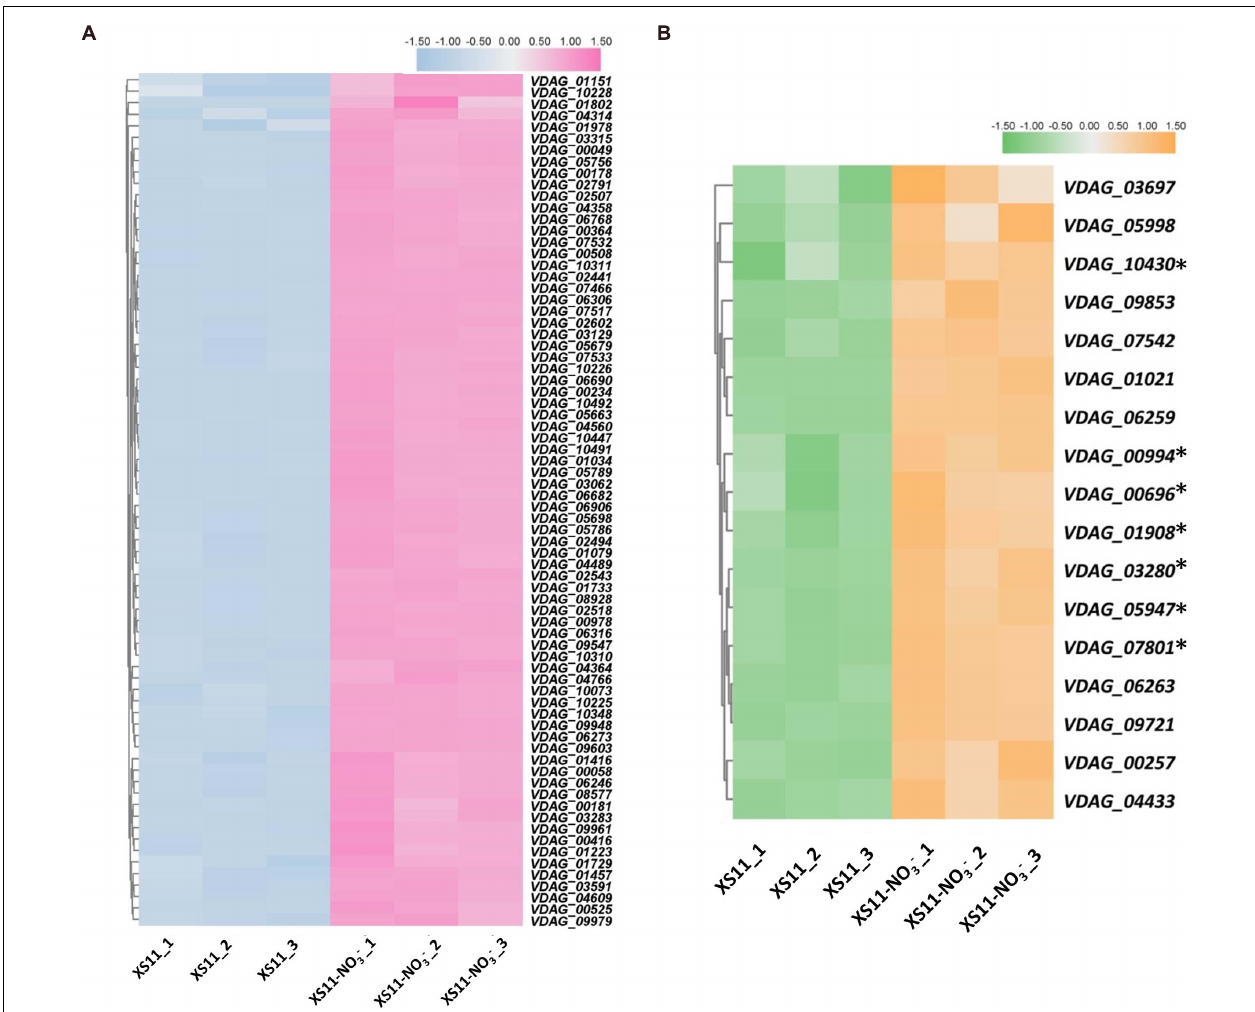
FIGURE 5 | Heat maps of differentially expressed genes related to ribosome and RNA polymerase processes in response to nitrate as the sole nitrogen source in Verticillium dahliae. (A) Heat map showing the relative expression of genes related to ribosome in the V. dahliae XS11 strain using nitrate (NO 3 − ) and in the control. TBtools was used to normalized data and generate heat map. The pink color indicates expression was relatively higher, while blue color indicates expression was relatively lower. White indicates that the gene expression between conditions analyzed was unchanged. (B) Heatmap of comparing expression of genes involved in RNA polymerase in nitrate metabolism. TBtools was used to normalized data and generate heat map. The orange color in the heat map indicates expression was relatively higher, while the green color in the heat map indicates expression was relatively lower. The white color indicates that the gene expression between conditions analyzed was unchanged. ∗ Means the key genes in RNA